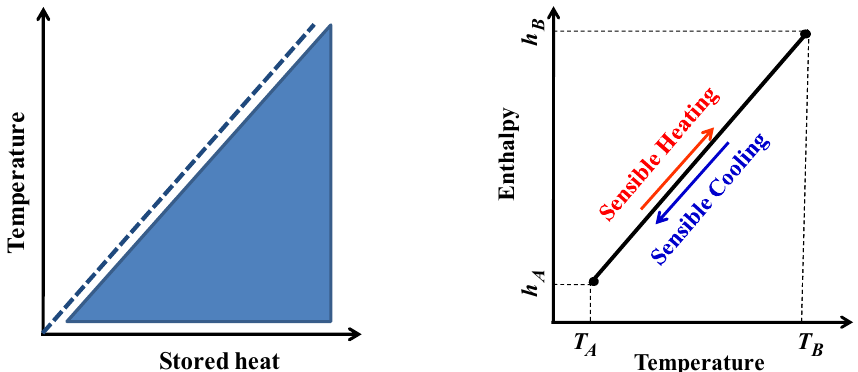
Figure 4. SHS typical diagram during sensible heating or cooling with no phase transition.